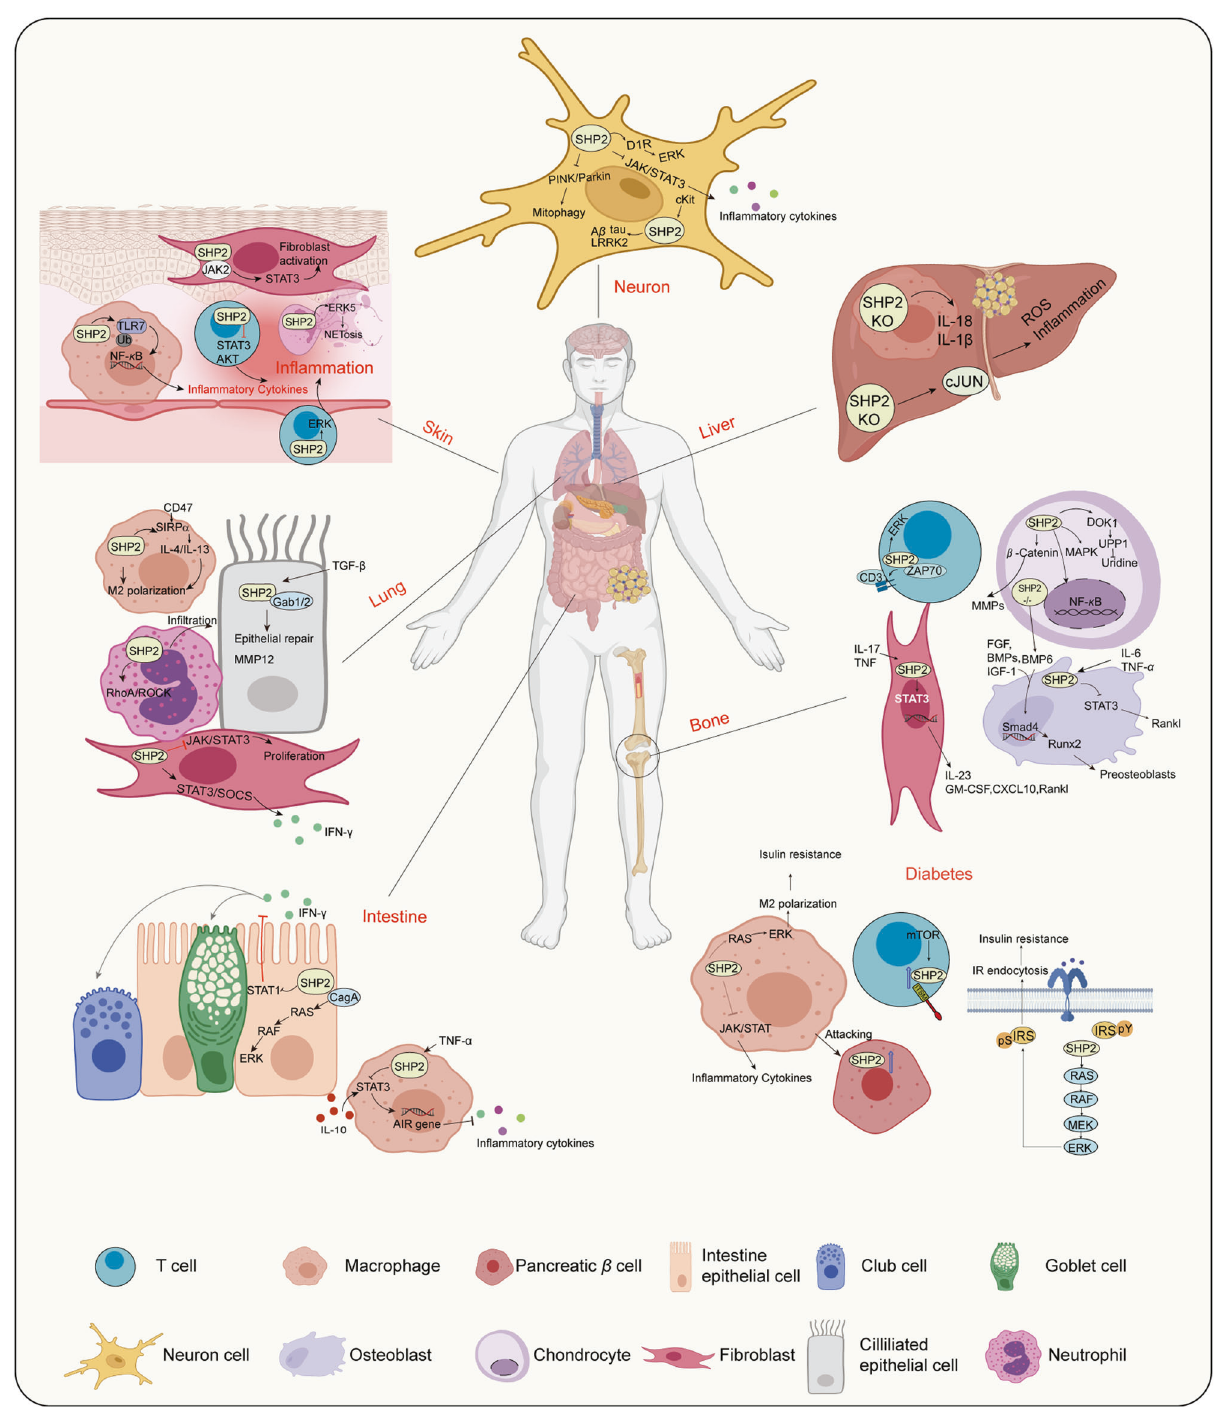
Therefore, strategies aimed at controlling SHP2 activity are pivotal. The most popular and advanced methods currently involve the use of SHP2 inhibitors, as discussed in the following